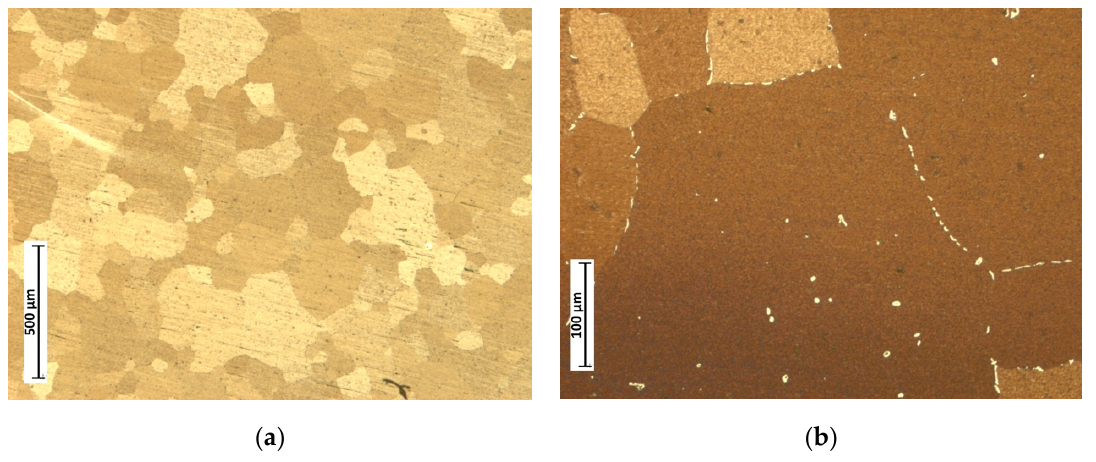
Figure 10. Microstructures after chemical etching of molybdenum powder sintered at 1900 ◦ C under 70 MPa pressure: ( a ) without a holding time and ( b ) with a 30 min holding time in both cases at the sample